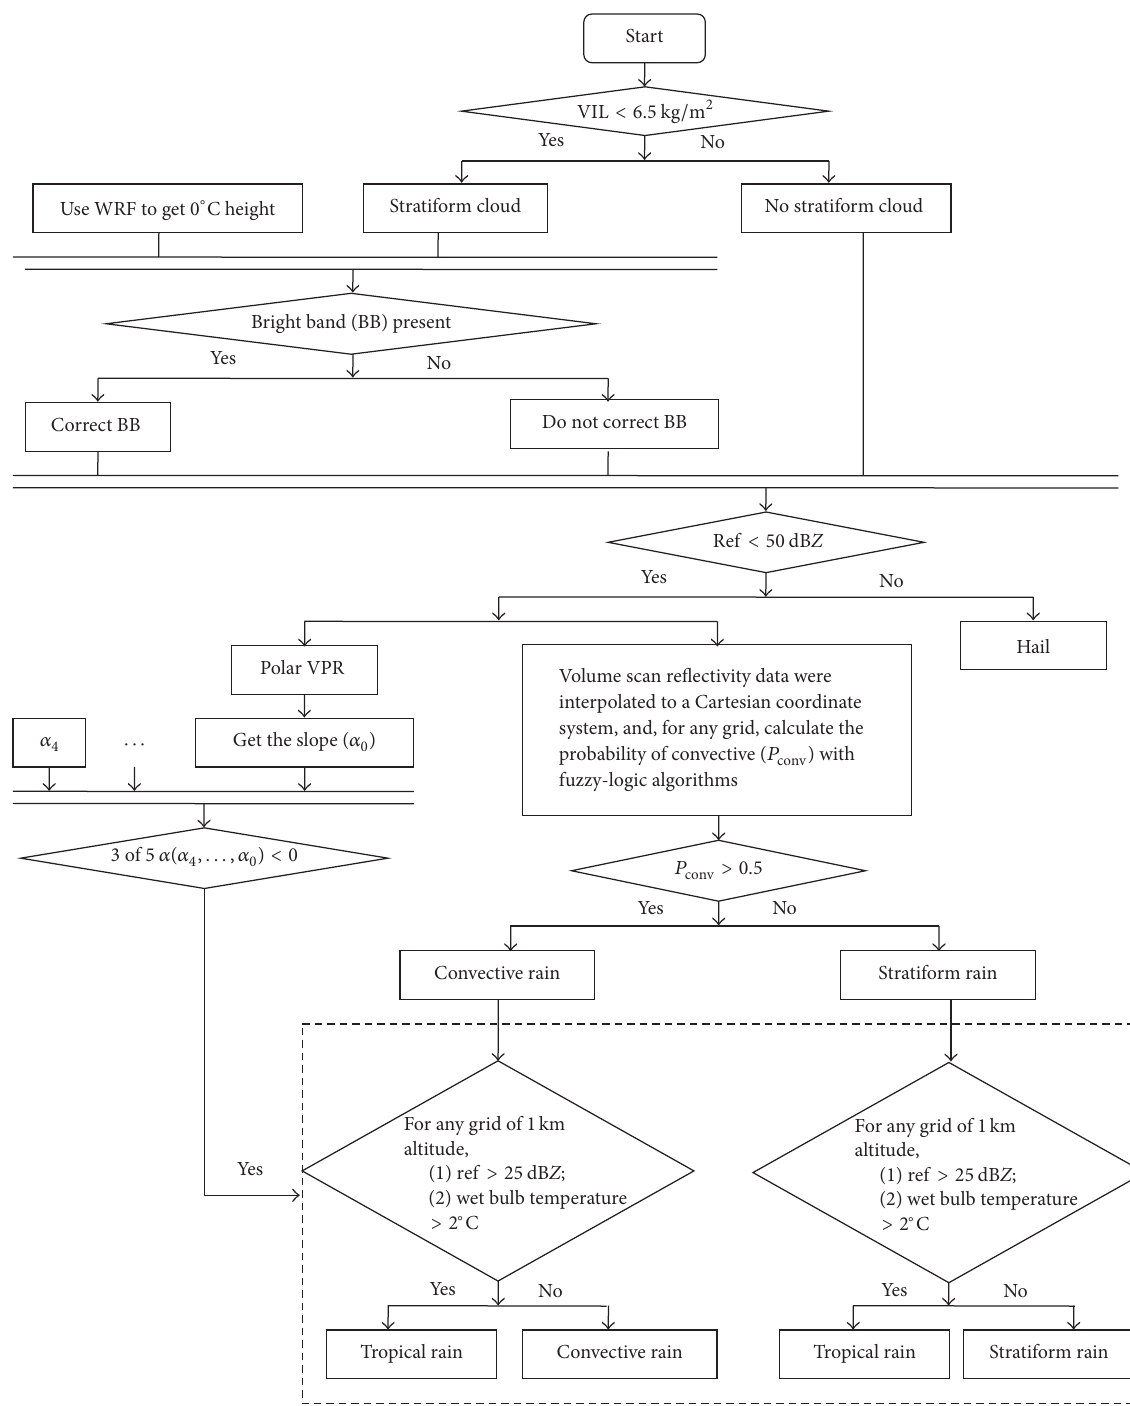
Figure 1: Flow chart of the precipitation classification method devised in this